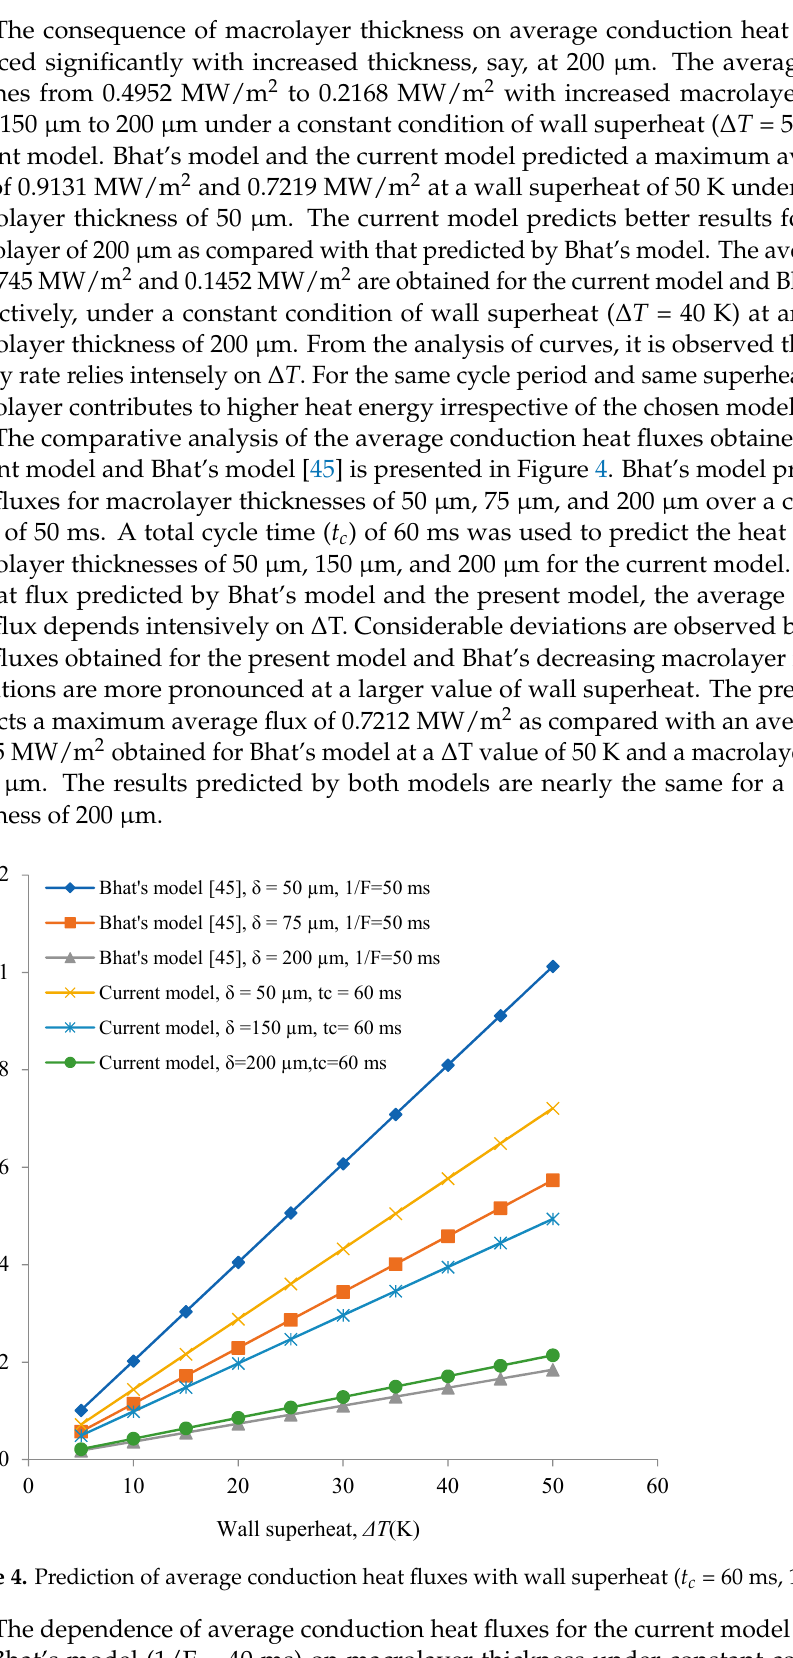
Figure 5. Dependence of average conduction heat fluxes on macrolayer thickness ( t c = 40 ms, 1/F = 40 ms).